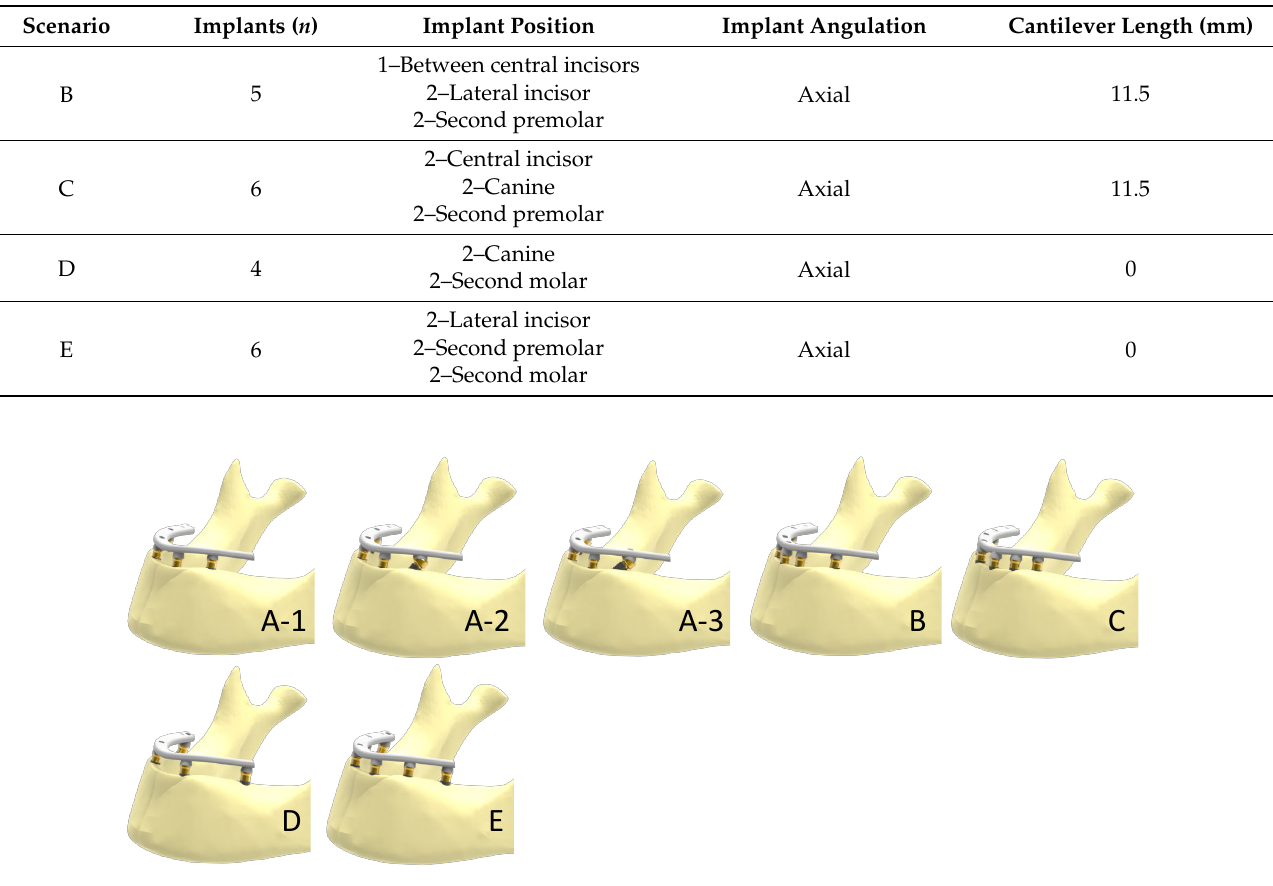
Figure 1. Above—scenarios with all implants between foramina. A-1: 4 implants. A-2: 4 implants, with posterior implants tilted 30°, keeping the fulcrum shaft at the same point as in case A-1. A-3: 4 implants, with posterior implants tilted 45°, keeping the fulcrum shaft at the same point as in